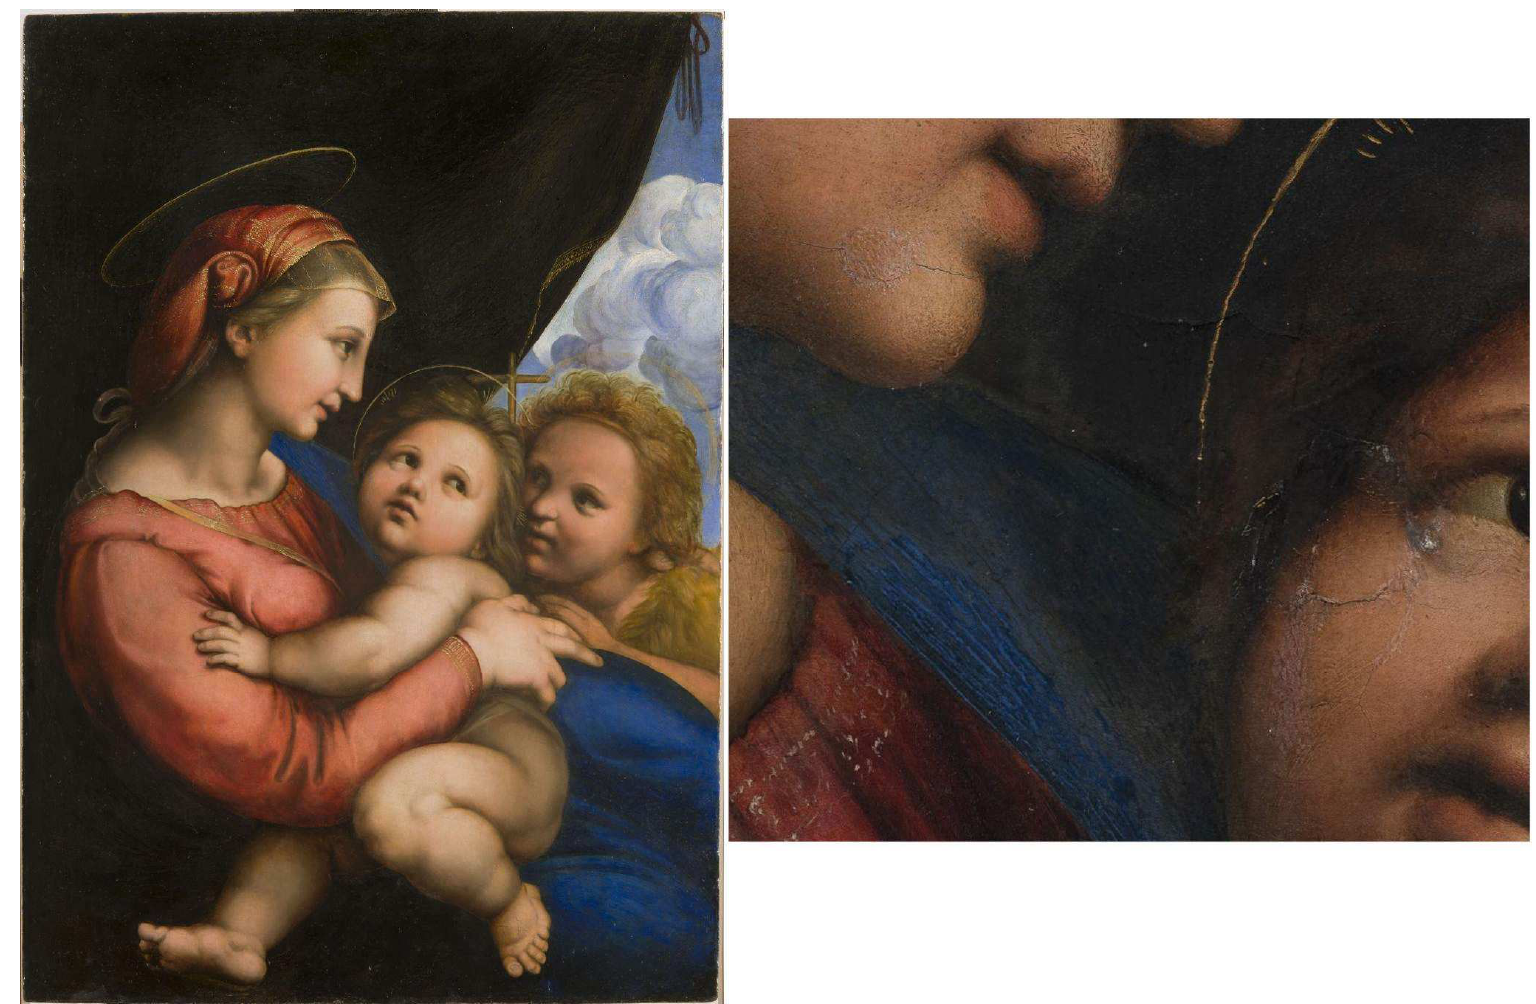
Figure 1. The panel painting Madonna della Tenda (Turin, Musei Reali–Galleria Sabauda, Inv. 271) and a detail of the state of preservation.